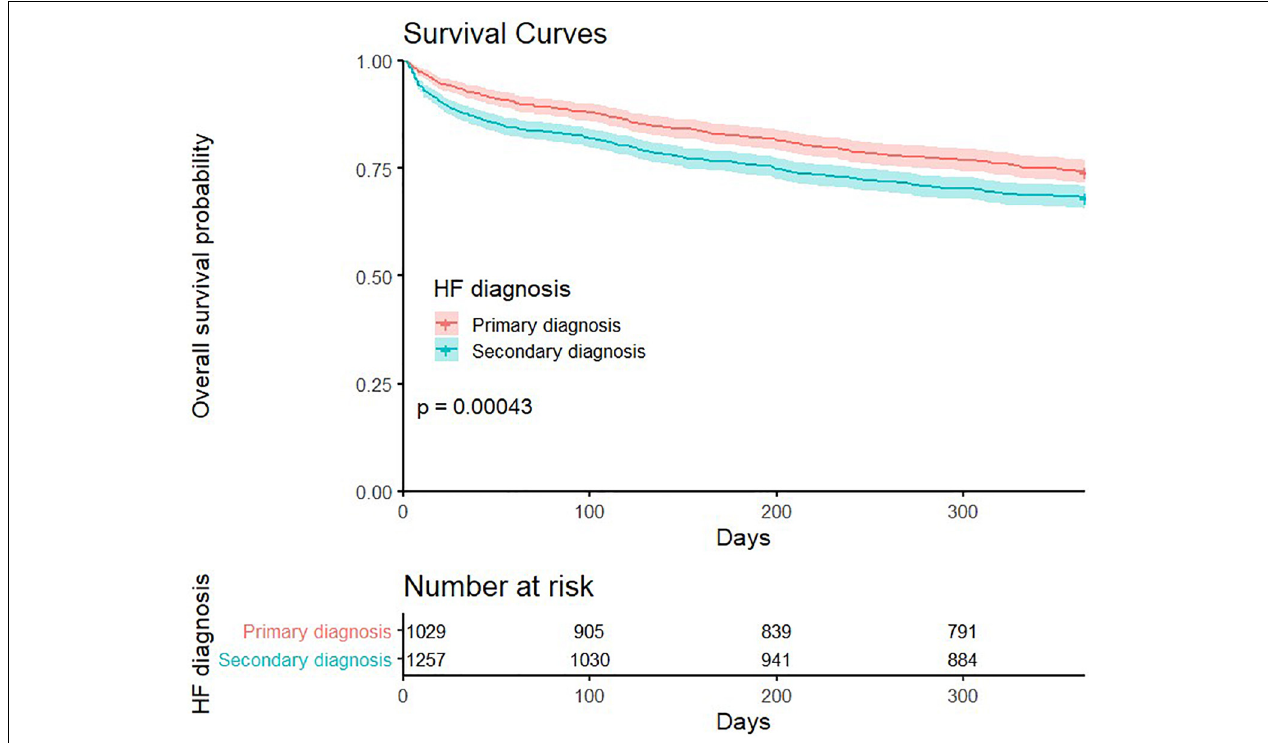
FIGURE 3 | Survival curves for hospitalized patients according to the type of heart failure diagnosis: primary and secondary.